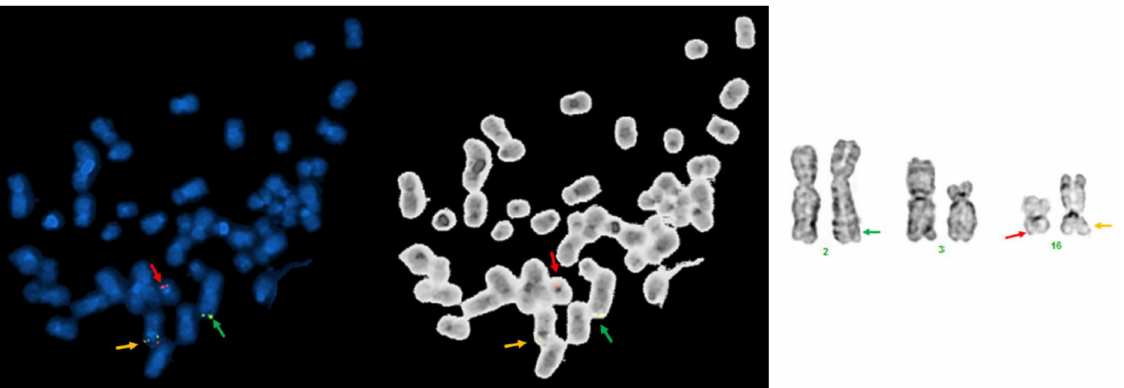
Figure 3. CBFB BAP FISH Images. A metaphase CBFB BAP FISH ( left ) and its inverted ( middle ) images are included. Each signal was also labelled on the corresponding chromosomes, as well as their band levels ( right ), to better understand the exact location of each signal. Red: 5 (cid:48) CBFB; green: 3 (cid:48) CBFB; orange: intact CBFB without